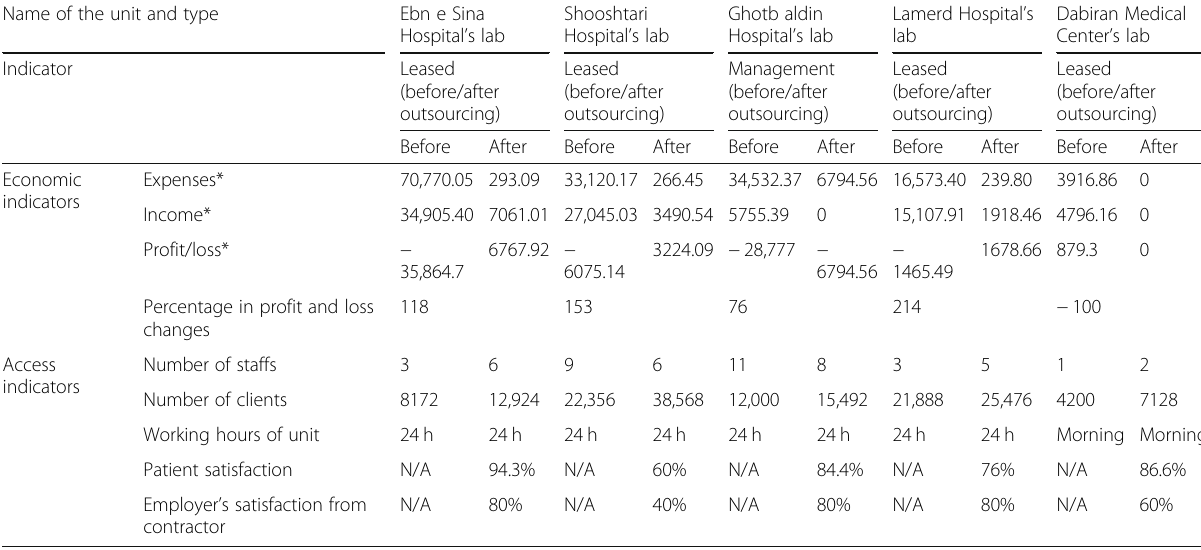
Table 3 Comparison of the lab ’ s performance in Shiraz University of Medical Sciences before and after the outsourcing, Iran, 2010 – 2012 Name of the unit and type